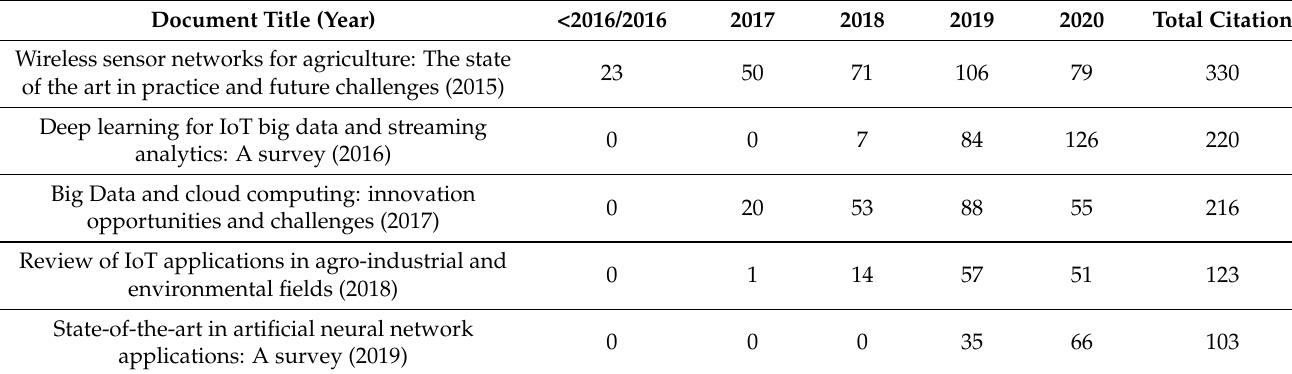
Figure 12. Year-wise statistics of publication citations for IoT in agriculture. Table 7. Statistical analysis of top five publications based on citations for IOT in agriculture.